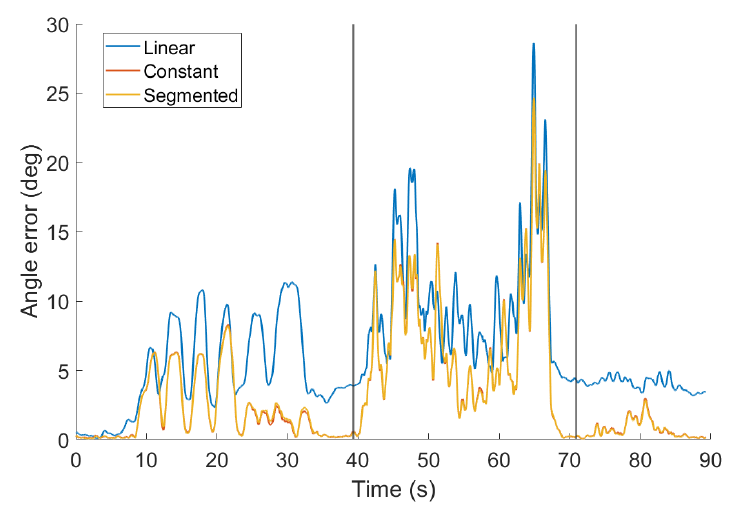
Figure 6. Accuracy of the separated correction filter (SCF) for scenario 3 and three different choices of the correction function: Linear, constant, and segmented. Parameters of all filters were tuned for the best overall performance.